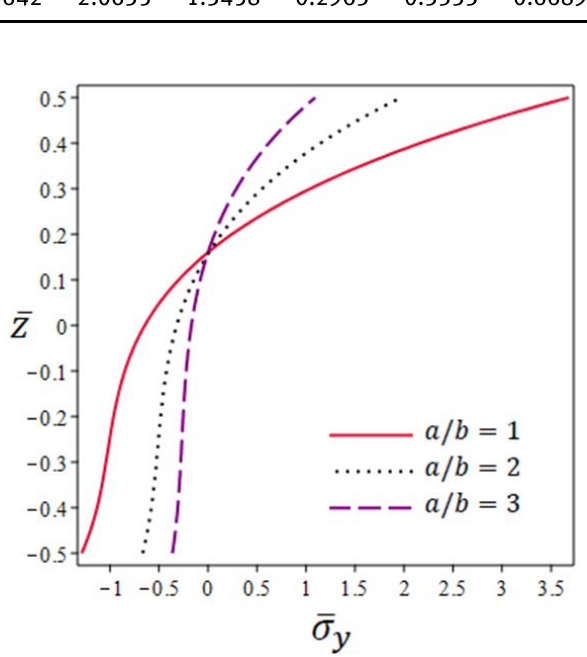
Figure 3: The axial stress σ x across the thickness of a square FG plate with k = 2 .